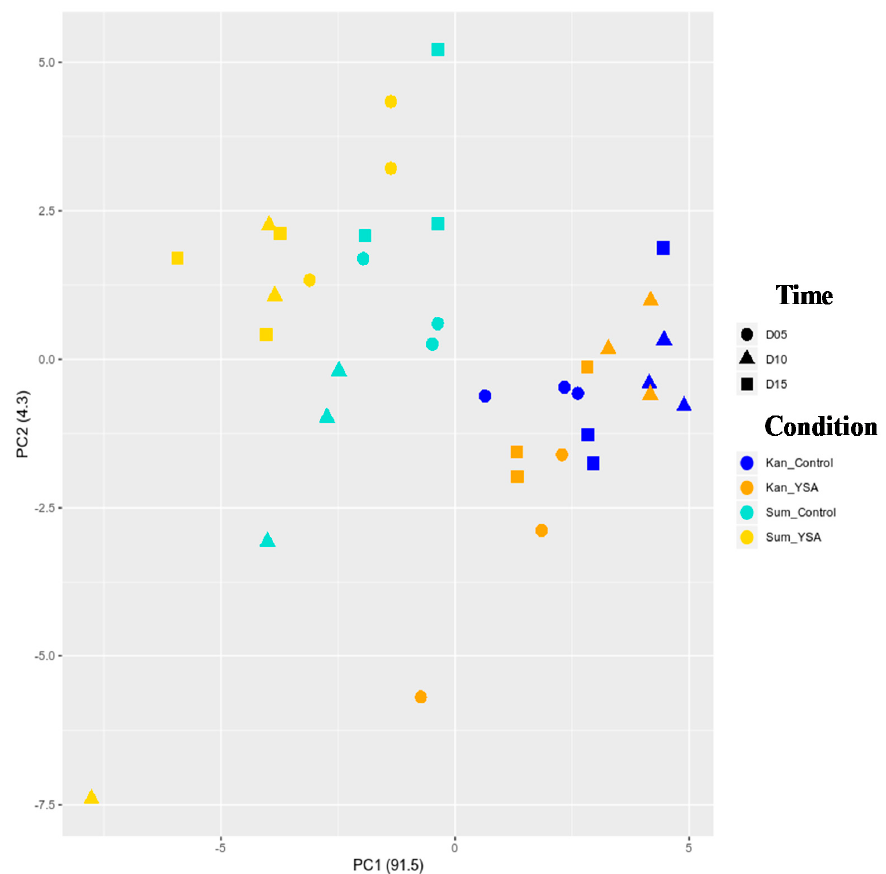
Figure 3. Principal component analysis (PCA) of the 40,657 expressed genes. Conditions are represented with colors (Kanlow control = blue, Kanlow infested = orange, Summer control = turquoise, and Summer infested = yellow) and the time with the shape (5 days = circle, 10 days = triangle, 15 days = square).